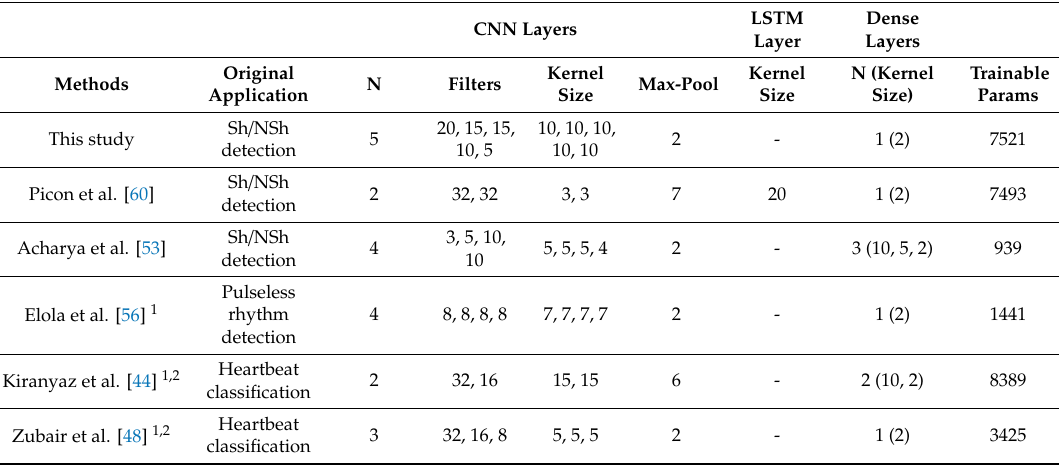
Table 5. Configurations of published CNN networks for ECG arrhythmia classification, which are further subjected to training and evaluation with our databases for shockable or nonshockable rhythm (Sh / NSh) detection.